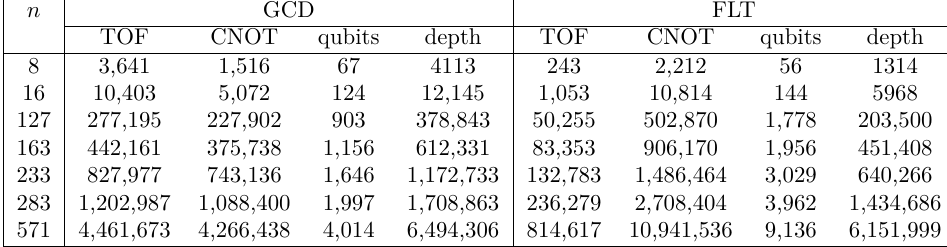
Table 2: Comparison of various instances of division Algorithms 1 and 2. Field polynomials from Table 1. Depths and gate count are upper bounds since a generic algorithm is used rather than optimizing for specific